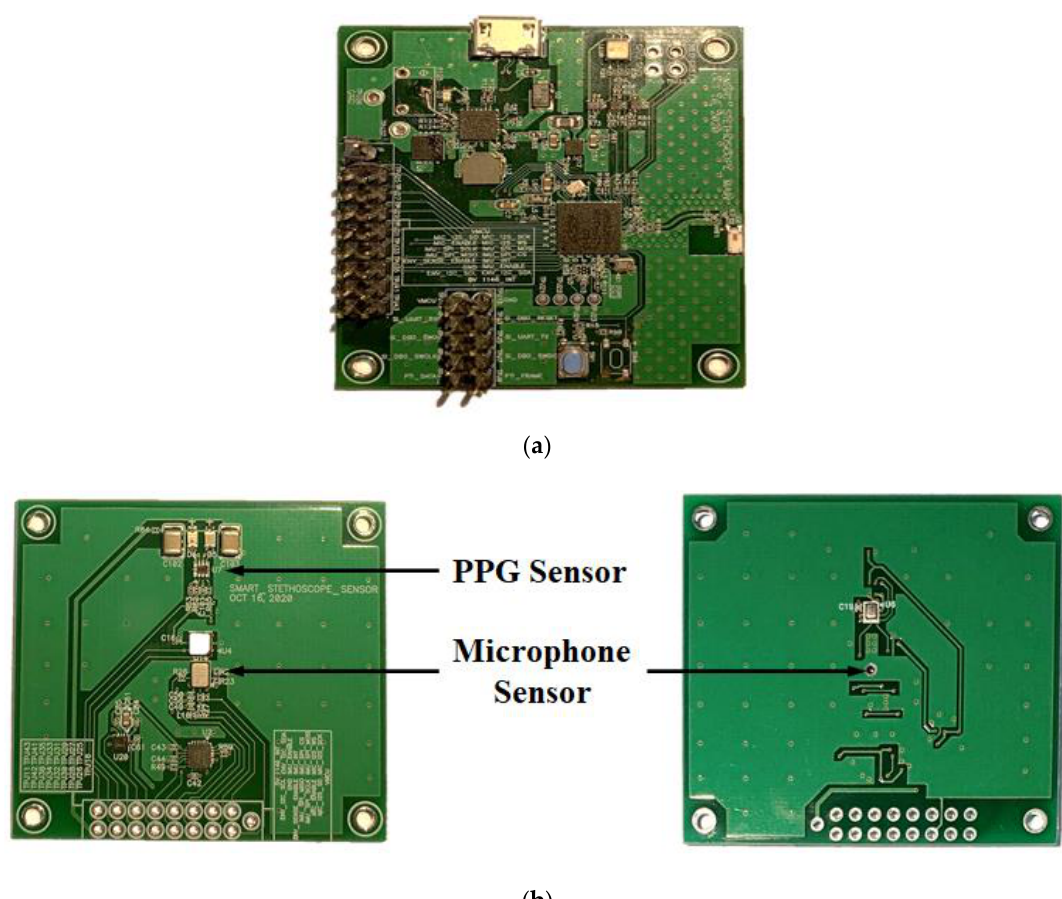
Sensors 2021 , 21 , x FOR PEER REVIEW Figure 6. Pictures of the manufactured smart stethoscope PCB: ( a ) PCB of the main part; ( b ) PCB of the sensor part.